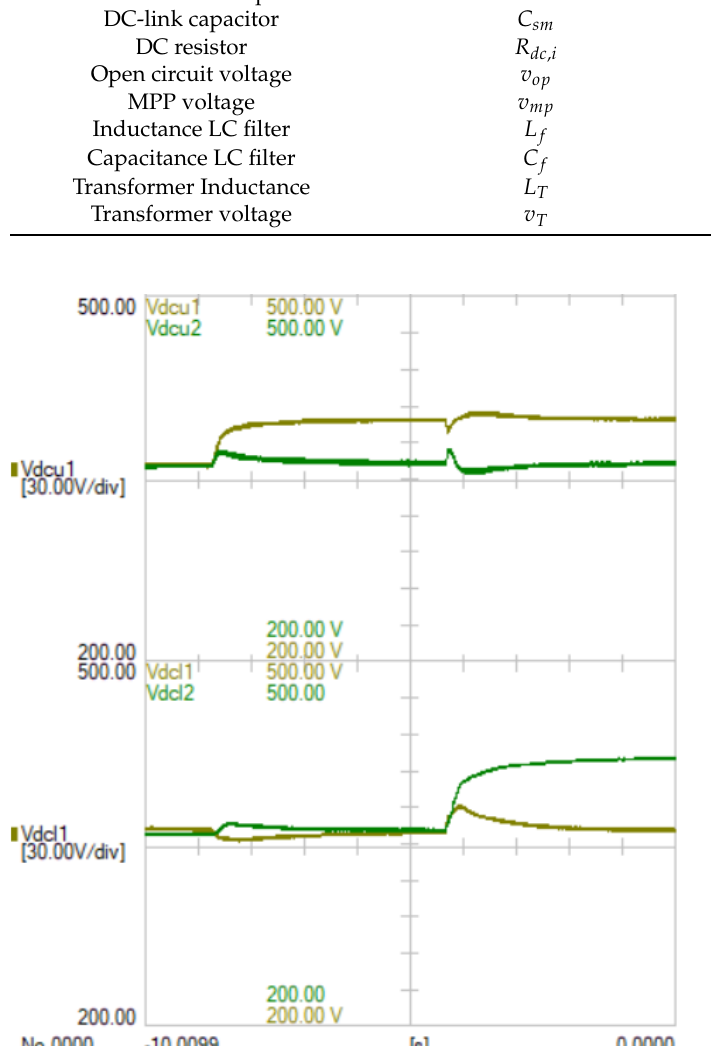
Figure 13. DC voltage step in the first module of the upper arm and the second module of the lower